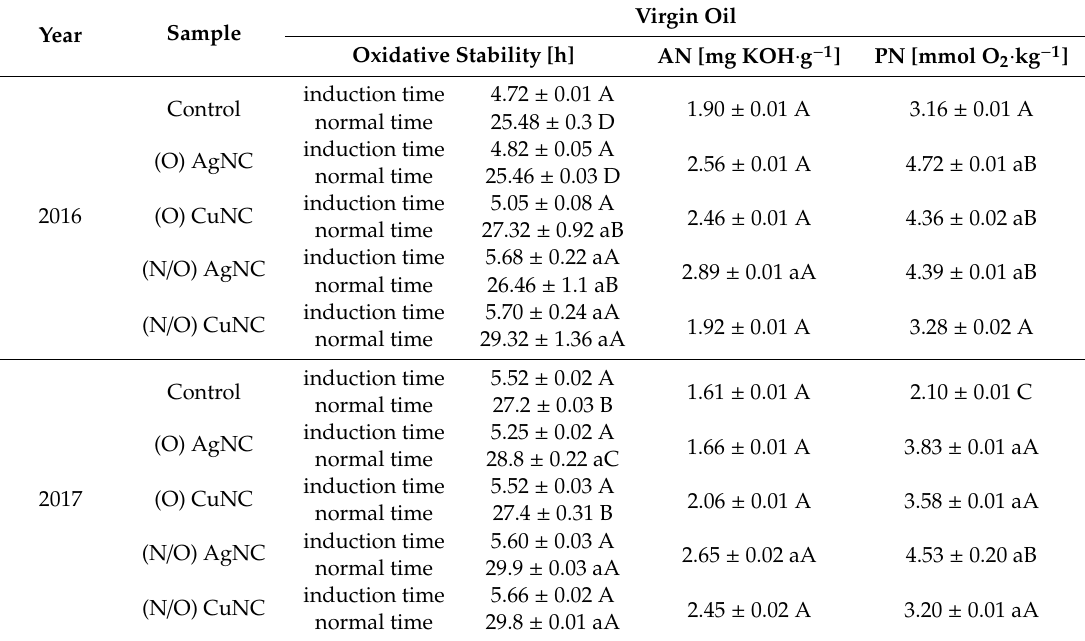
Table 3. Acid number, peroxide number and oil induction